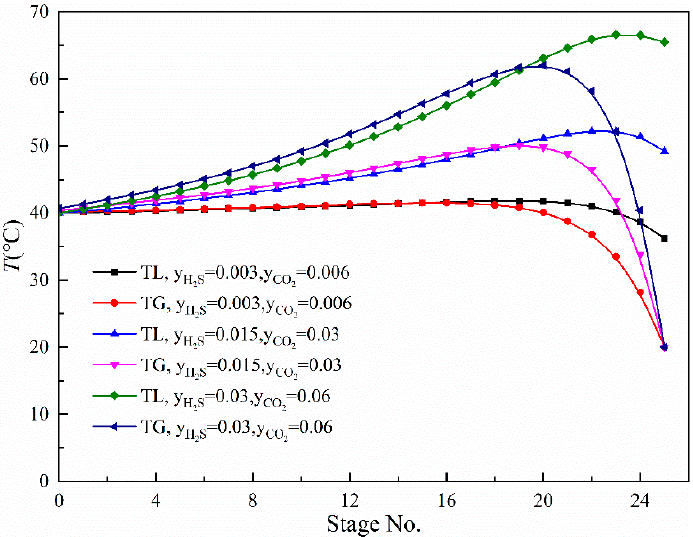
Figure 10. The gas–liquid temperature profile of each component in the absorption column (overflow weir height: 0.15 m; absorption pressure: 6 MPa; inlet gas flow rate: 5.0 × 10 6 Nm 3 /d; inlet gas–liquid ratio: